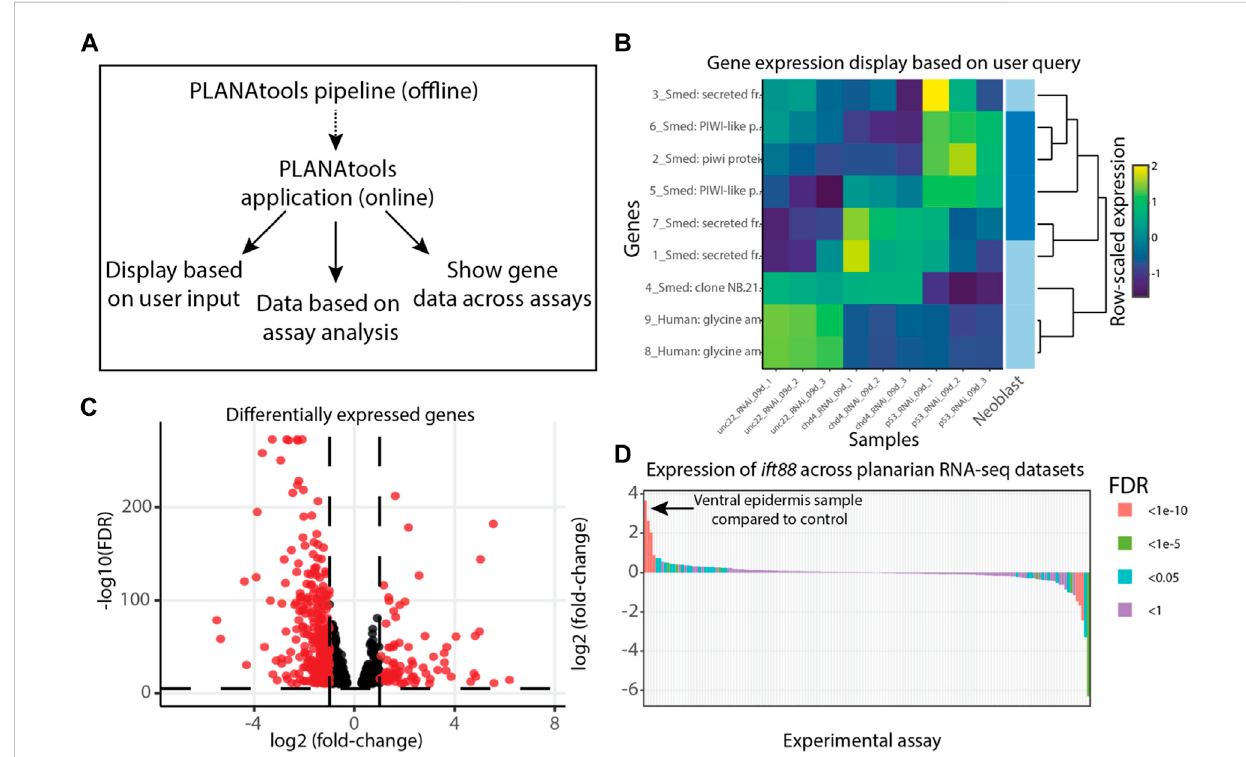
FIGURE 1 Overview of PLANAtools. (A) Main functions of PLANAtools. An asynchronous standardized pipeline was designed for of fl ine RNA-Seq data processing. The products of this pipeline are used in the online application. Main functions of the online application are shown. (B – D) Images produced by PLANAtools were minimally edited for assembling the multi-panel fi gure; in the application the plots are interactive and show additional information upon mouse hover. (B) Data visualization produced using the heatmaply package (Galili et al., 2018) on user queried transcripts, using published planarian gene expression data (Tu et al., 2015) that is available on PLANAtools. The right column of the heatmap highlights genes that are known to be expressedin a user selected cell type (Fincher et al., 2018); dark and light blue, expressed or not expressedspeci fi cally in the cell type, respectively; in the exampleshown,theselectedcelltypeisneoblast. (C) Avolcanoplotshowingdifferentiallyexpressedgenesinre-analysisofpreviouslypublisheddata(Tu et al., 2015) at 9 days following inhibition of CHD4 expression. Black and red, signi fi cant and insigni fi cant changes to gene expression, based on user parameters,respectively. (D) Differentialexpressionofauserqueriedgene( Smed-ift88 )isshownacrossallavailableRNA-SeqassaysinPLANAtools.Each bar represents a single assay comparing expression in the condition compared to its control. Bar color represents the signi fi cance of the differential expression in that assay. The arrow indicates the largest increase in gene expression observed across all assays. The expression of ift88 is highly enriched in the ventral epidermis compared to its control (Wurtzel et al.,